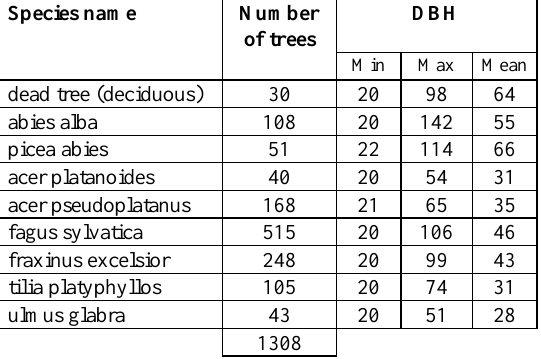
Table 1. Overview of the field inventory data in Leageren